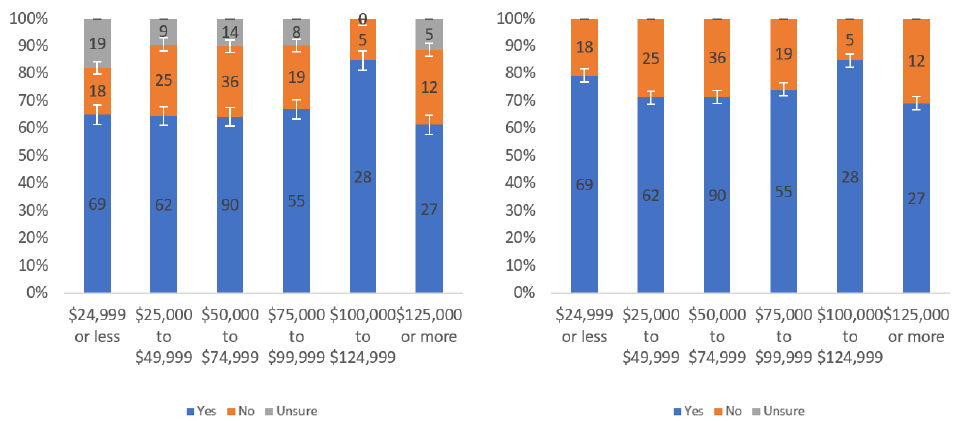
Figure 23. Responses regarding label helpfulness by income level including ( left ) and excluding ( right ) unsure responses.